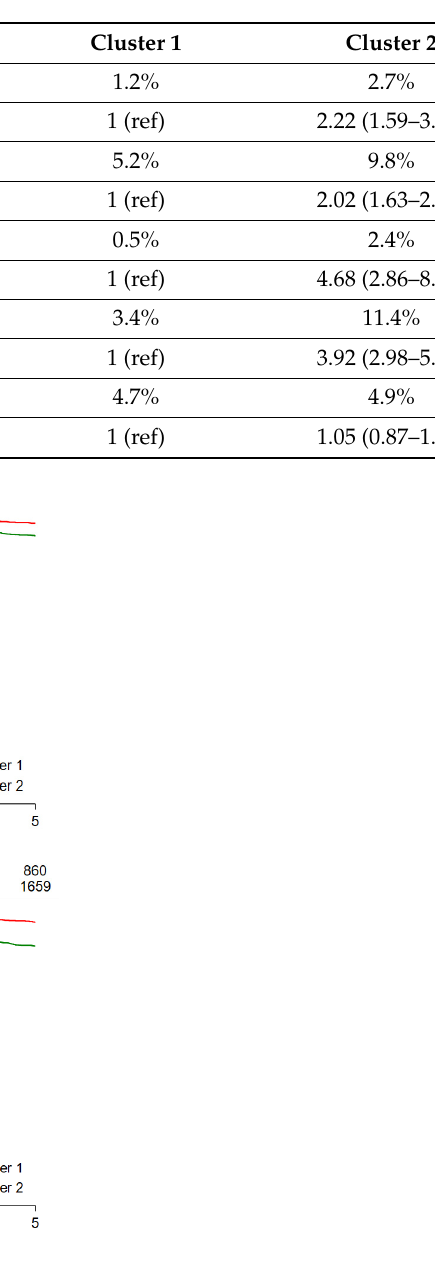
Table 2. Post-transplant outcomes according to the clusters.